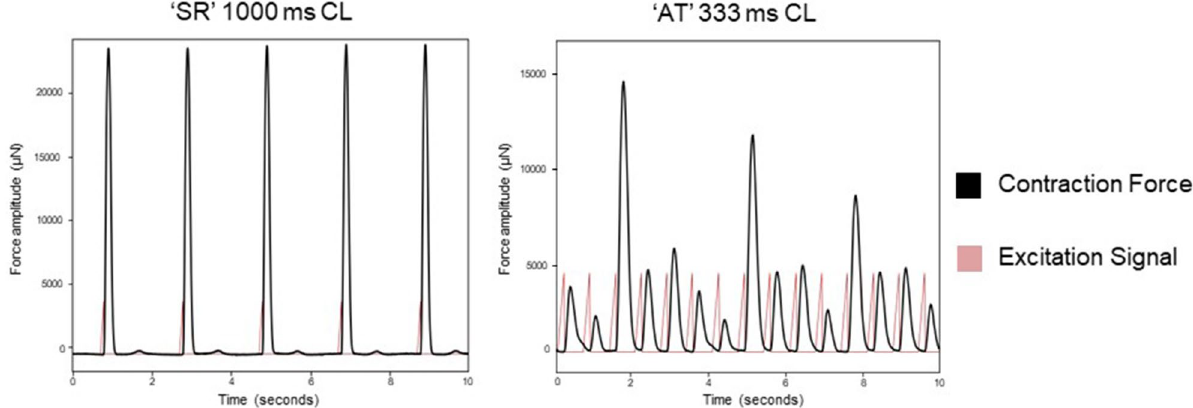
Figure 4. Atrial tachyarrhythmia (AT) model with stimulation at 333 ms CL versus 1000 ms CL as model for sinus rhythm (SR). Contraction force was decreased during tachypacing and there appeared to be more beat-to- beat